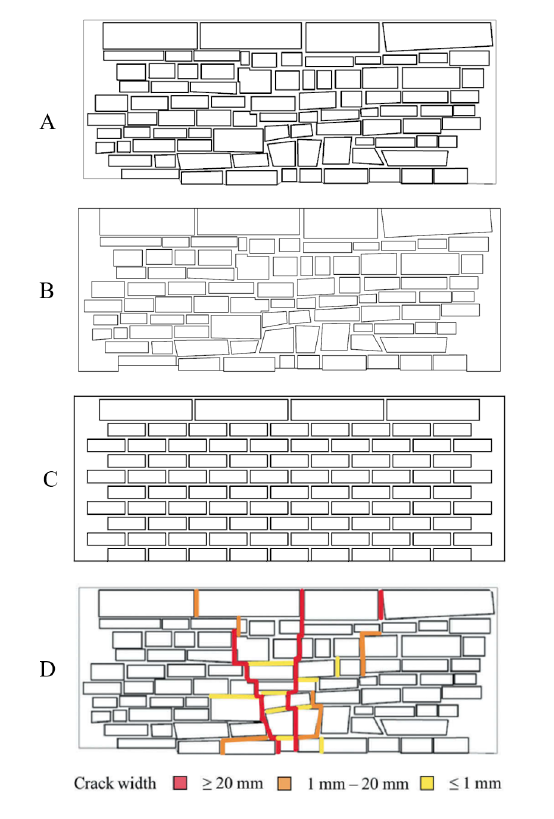
Figure 6. Existing geometry of the wall, B) Perturbed geometry, C) Isodomic geometry, D) Crack map. Figures adapted from (Napolitano et al.,